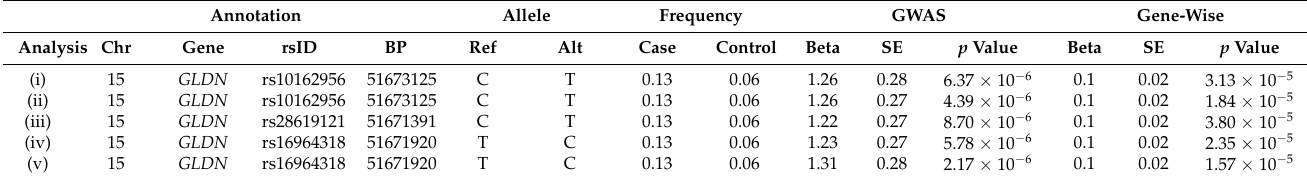
Analysis: industrial/occupational factors added in GWAS and gene-wise analysis in male bladder cancer: (i) 1 variable with 20 levels for industrial classification divisions; (ii) selected industrial classification divisions G and S for male bladder cancer; (iii) 1 variable with 12 levels for occupa-